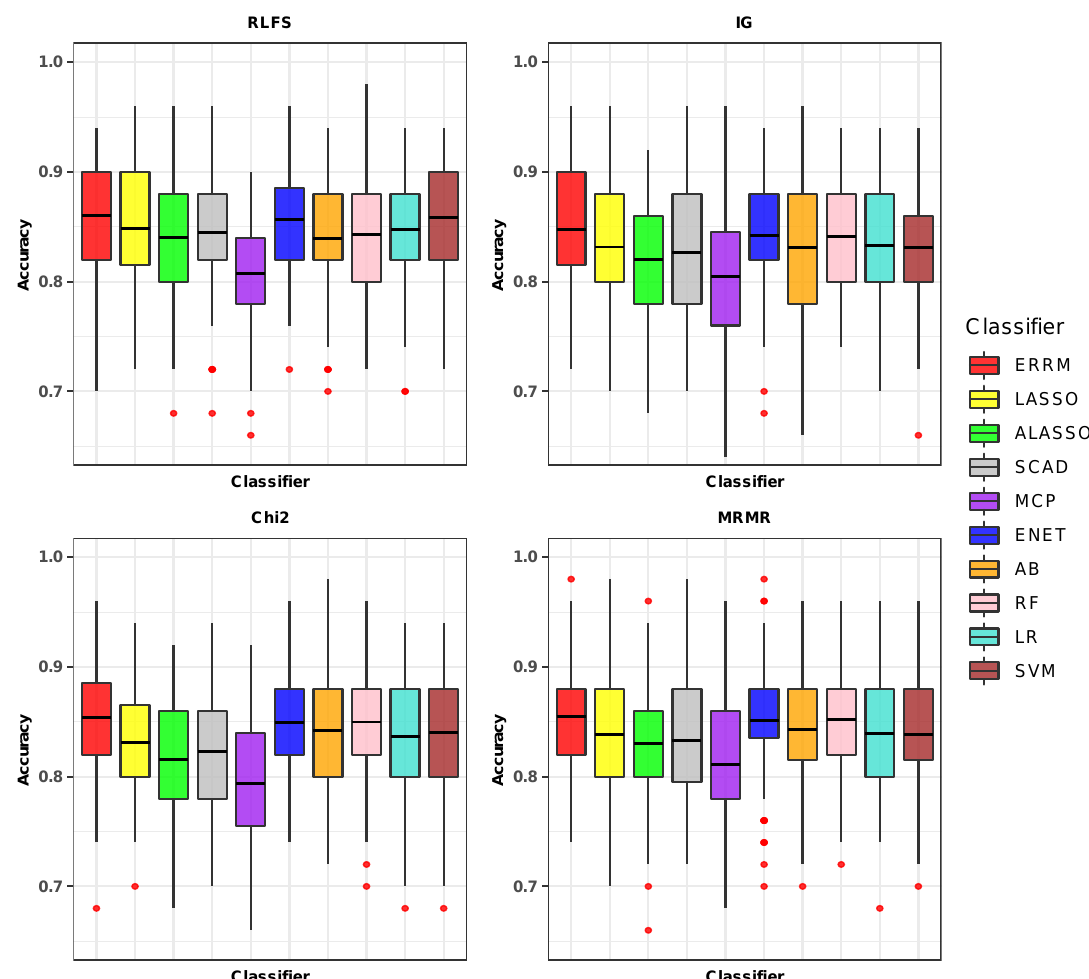
Figure 3. Comparison of accuracies of proposed combination of ensemble of regularized regression models (ERRM) with resampling-based lasso feature selection (RLFS) and other classifiers with feature selection methods when correlation =